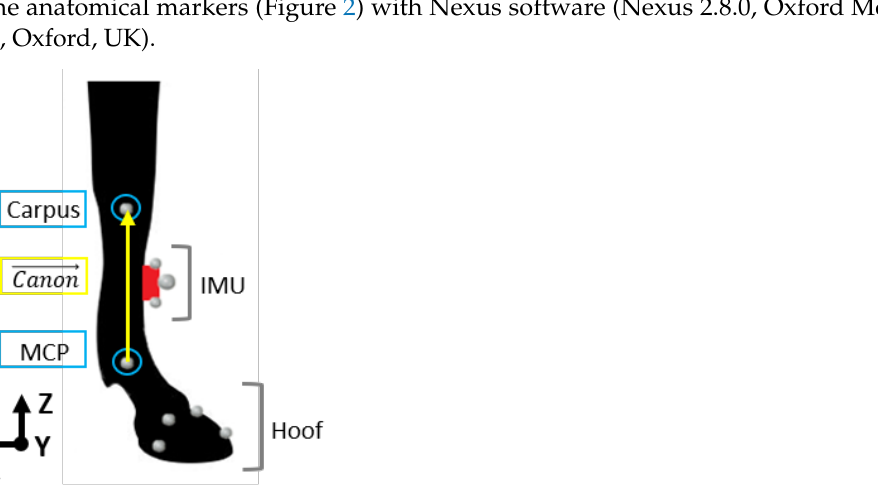
Figure 2. Positioning of the IMU (in red) and kinematic markers on the right front limb and orientation of the laboratory coordinate system ( x⃗ , y⃗ ,z ) . The markers were positioned on specific anatomical landmarks (lateral styloid process of the radius for the carpal joint (Carpus), lateral condyle for the metacarpophalangeal joint (MCP), hoof (toe, heel, front coronary band, lateral coro- nary band)) and on the IMU (center, up lateral part, down lateral part). The orientation of the canon bone (in yellow) was defined by the coordinates of the Carpus and MCP markers (in blue).